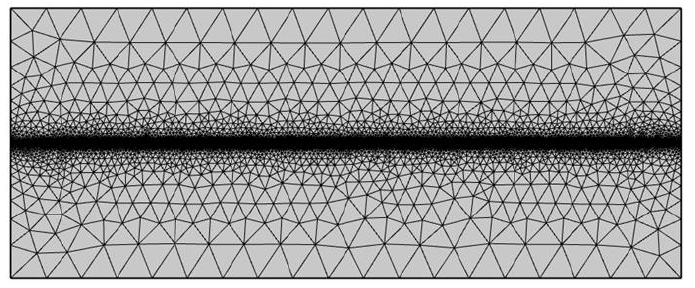
Figure 4. Finite elements for a laboratory-scale fractured medium, which has a dimension of 10 × 3 m (length × width).